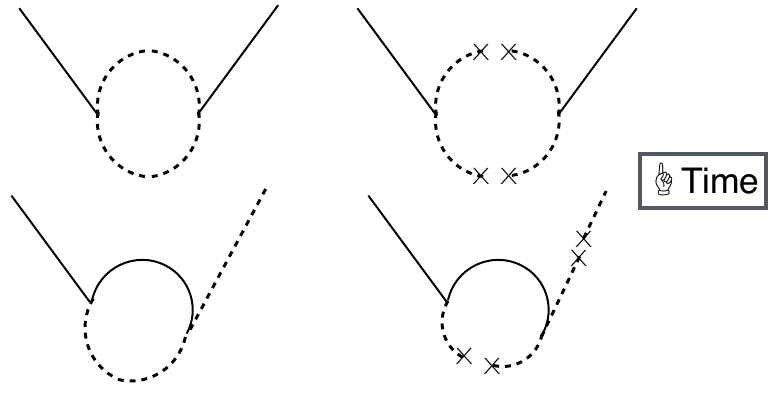
Figure 1 . Left: QFT Diagrams for (cid:13)owing upward in the graph. As explained in section 2, propagators are either retarded, G R (solid lines), or anticommutator, G + = all leading contributions to